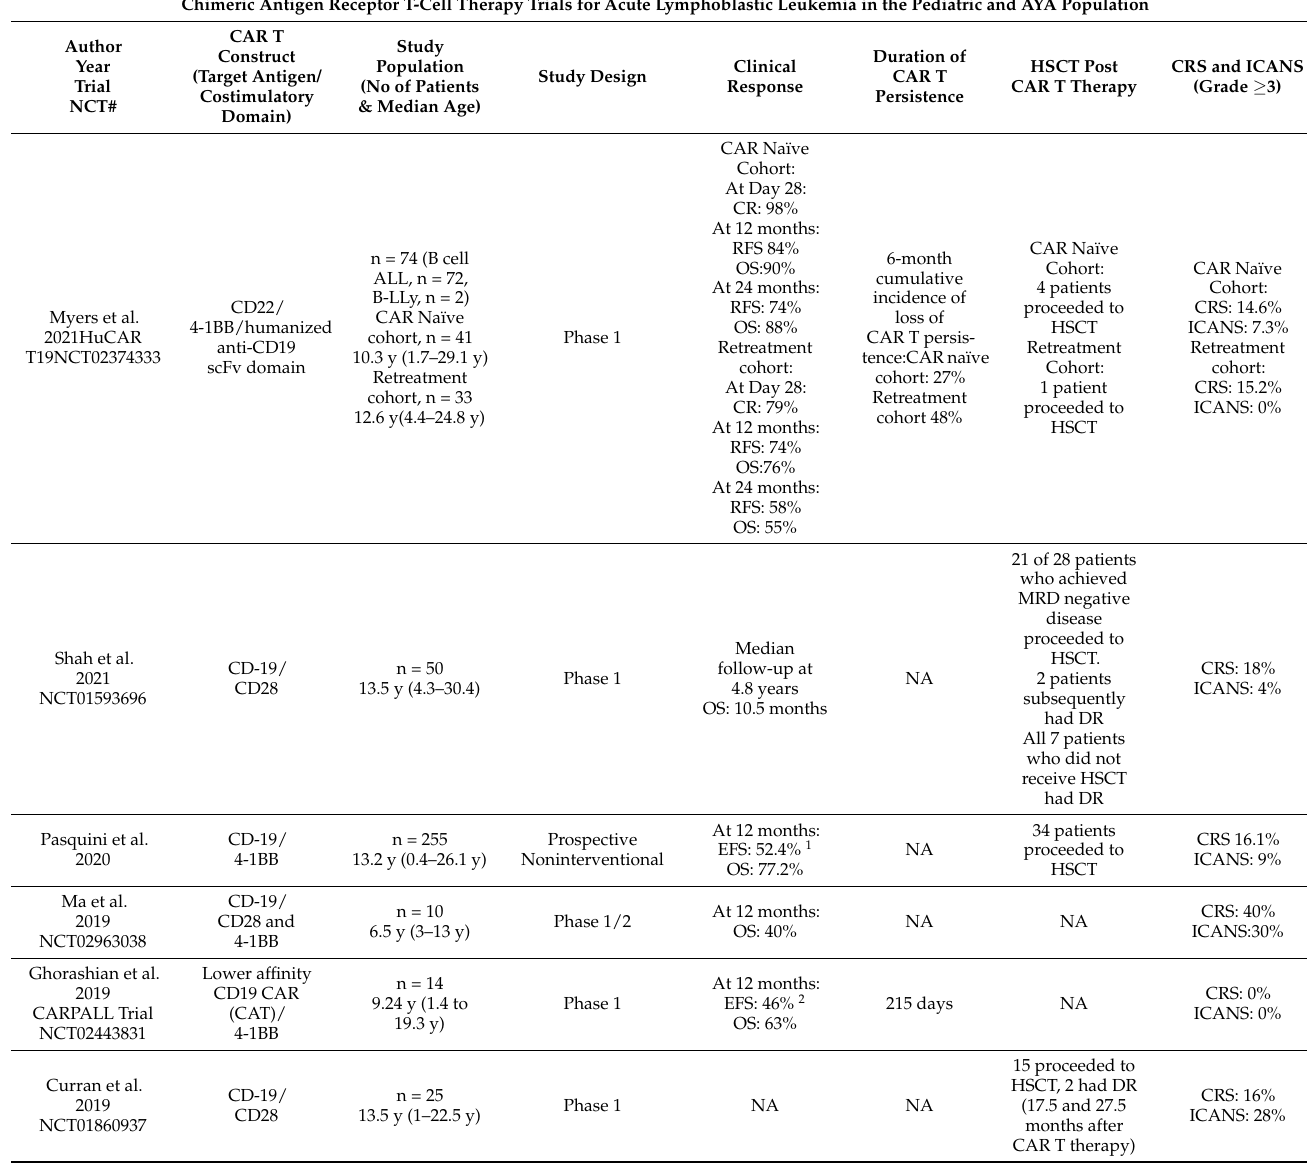
Table 2. Summary of clinical trials of chimeric antigen receptor T-cell therapy for acute lymphoblastic leukemia in the pediatric and AYA population